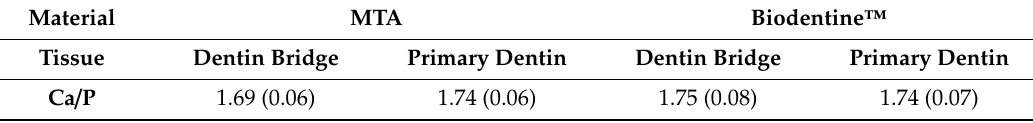
Figure 5. Representative Raman spectra of the dentin bridge (red line) and primary dentin (blue line) of the Biodentine™ group. The spectra were normalized based on the peak intensity of the CH 2 bending vibration at 1450 cm − 1 .